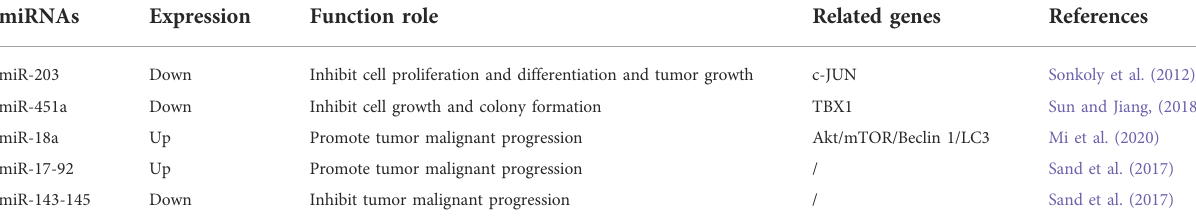
TABLE 1 Functional characterization of miRNAs in basal cell carcinoma. miRNAs